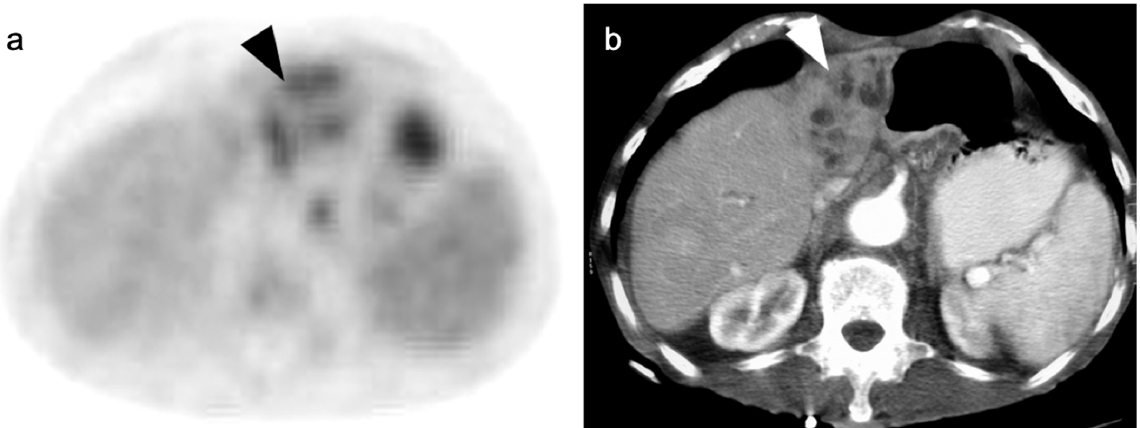
Figure 20. A small cholangiocarcinoma resulted in blockage of the bile ducts draining a portion of the left lobe of the liver. ( a ) Axial FDG PET of the upper abdomen shows hypermetabolic bile ducts (black arrowhead); ( b ) The bile ducts are dilated on axial contrast-enhanced CT (white arrowhead). The findings are consistent with post-obstructive focal cholangitis. This can result in a false-positive FDG PET-CT scan performed for cancer assessment.